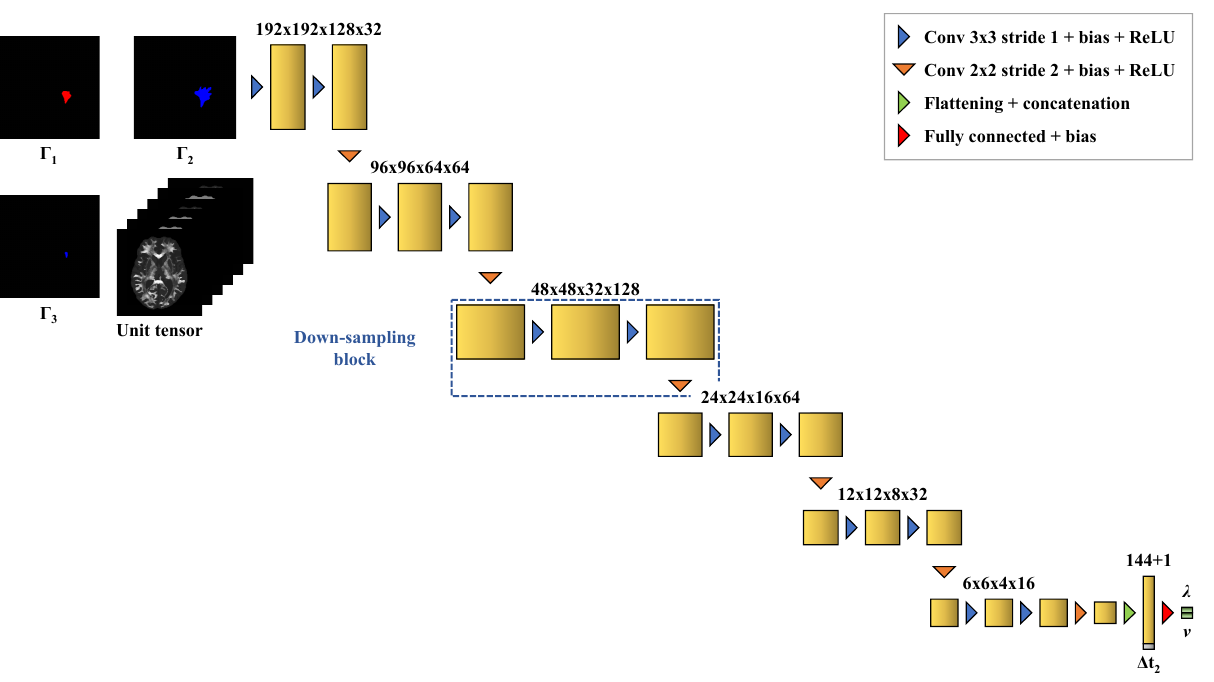
Figure 6. Three-dimensional convolutional regressor architecture with its feature map dimensions used for parameter estimation. The network takes as input volumes of dimensions 192 × 192 × 128 with 9 channels corresponding to the 3 contours Γ 1 , Γ 2 , and Γ 3 and the 6 independent components of the unit (unscaled) tumor cell diffusion tensor field as well as the time interval ∆ t 2 between Γ 3 and Γ 2 , and outputs estimated values of λ and v